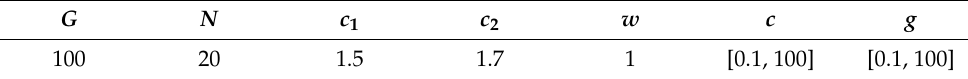
Table 5. Parameters of PSO-SVM.